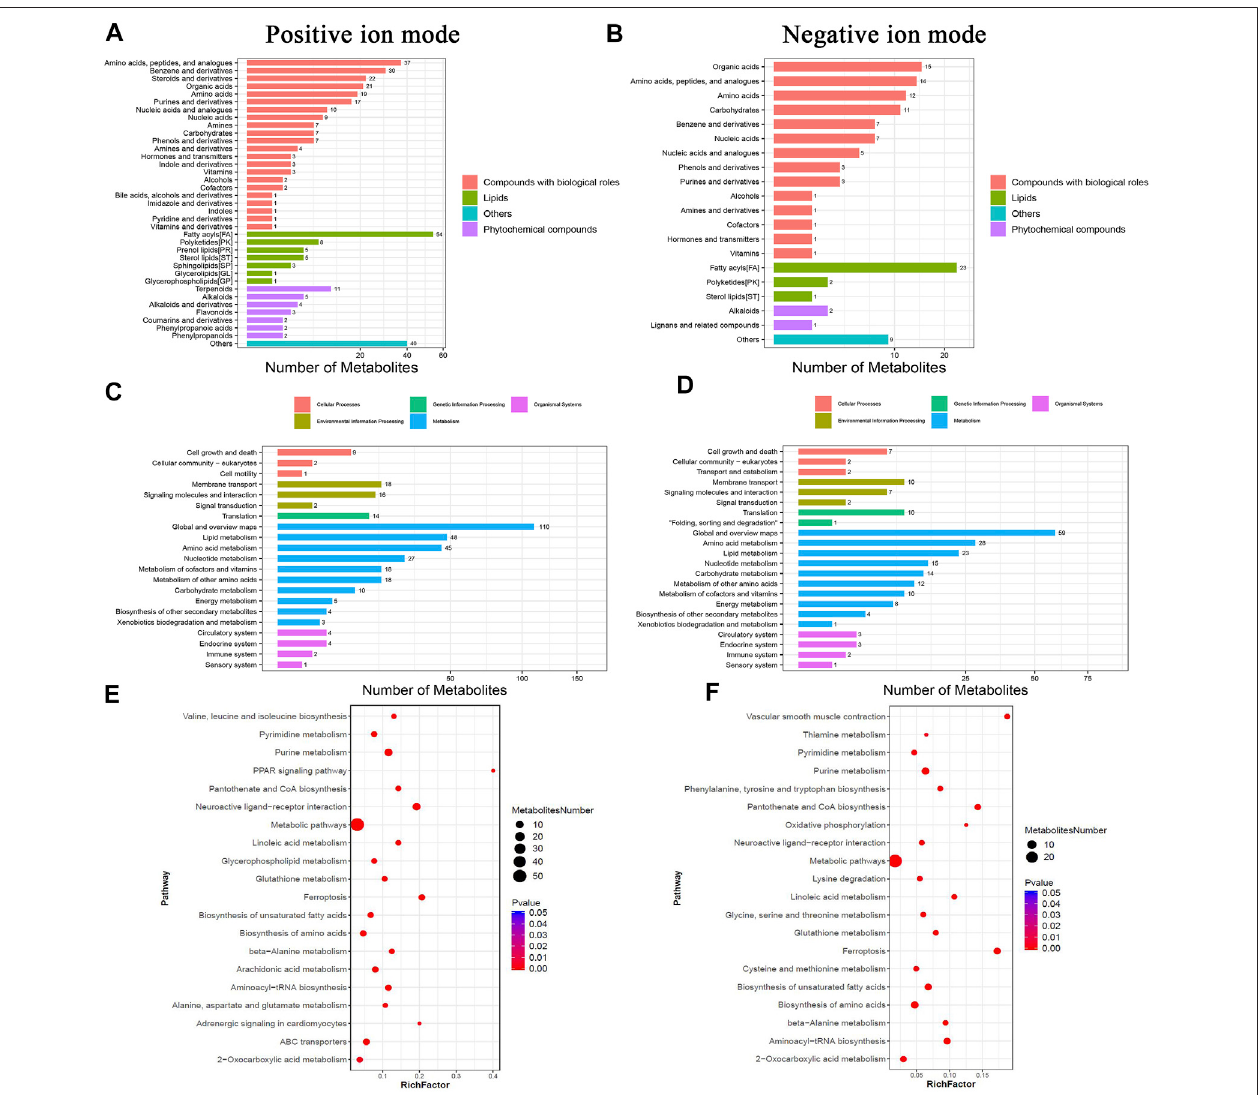
FIGURE5| Functional enrichmentanalyses ofDMs in chicken ovaryduring sexual maturity. Based onKEGG database, functional annotations wereperformed for DMs identi fi ed by positive and negative ion mode. (A,B) pathway annotation histogram, (C,D) DMs pathway classi fi cation, (E,F) signi fi cantly enriched pathway.